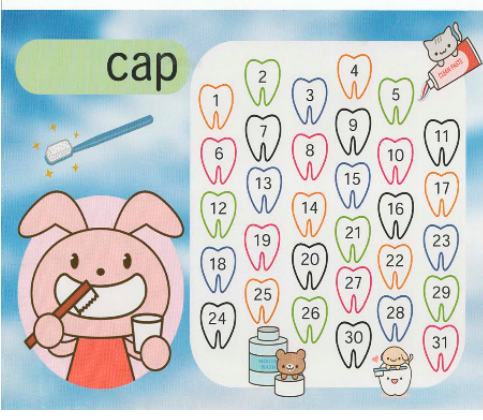
Figure 2. Tooth cleaning calendar.